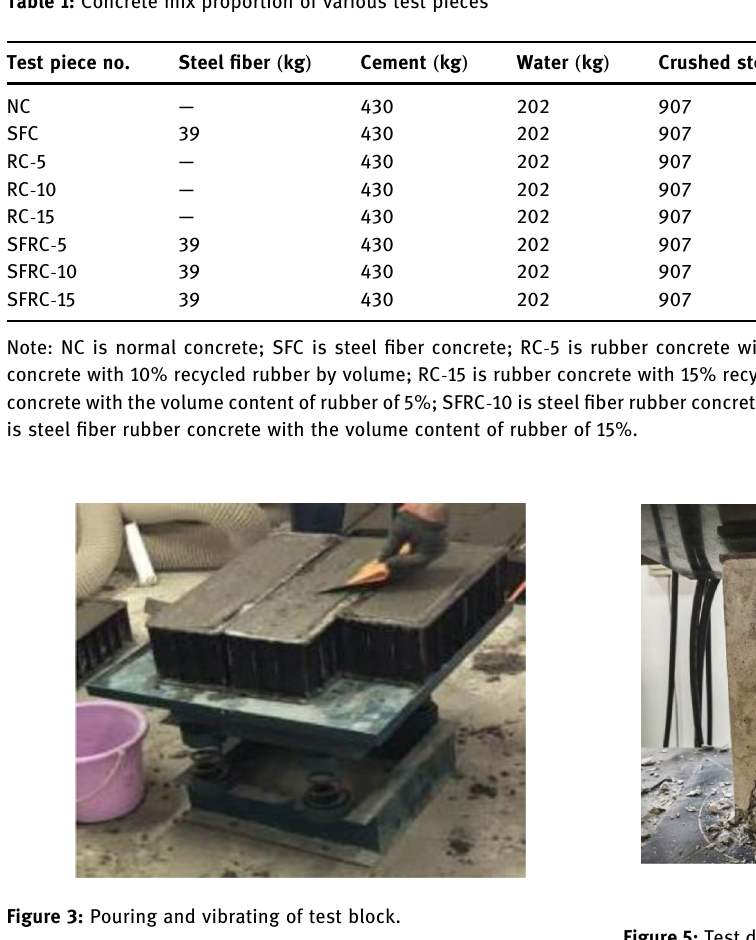
Figure 5: Test device of prismatic and cube samples. ( a ) Prism axial compression test; and ( b ) cube compression test.